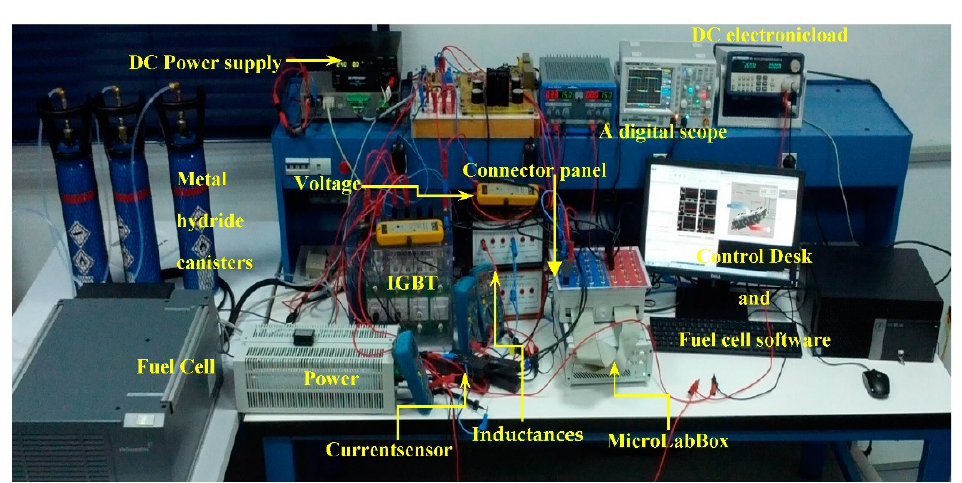
Figure 17. Laboratory prototype used for experimental validation. Table 4. Controlled system parameters.